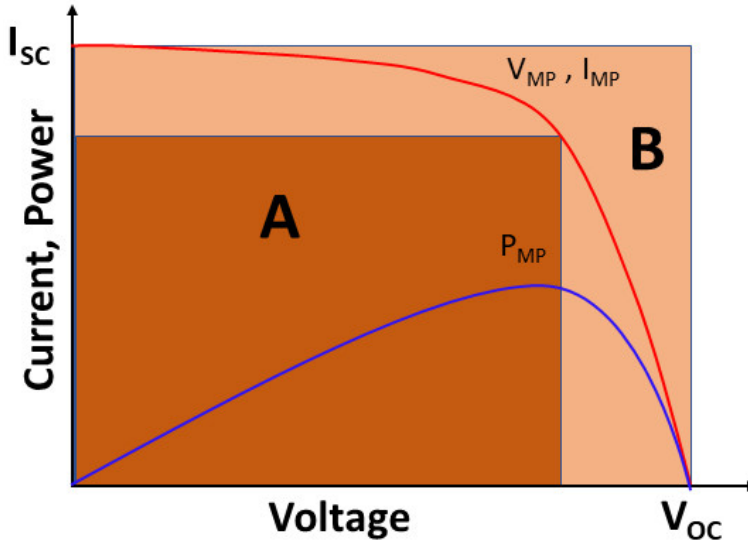
Figure 4 . Current voltage (IV) curve of organic solar cells. Figure 4. Current voltage (IV) curve of organic solar